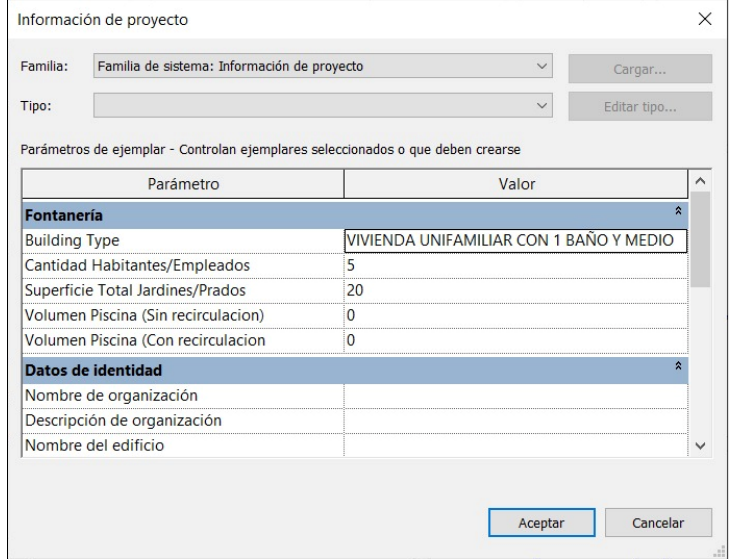
Figure 6. Project information chart for single-family house.